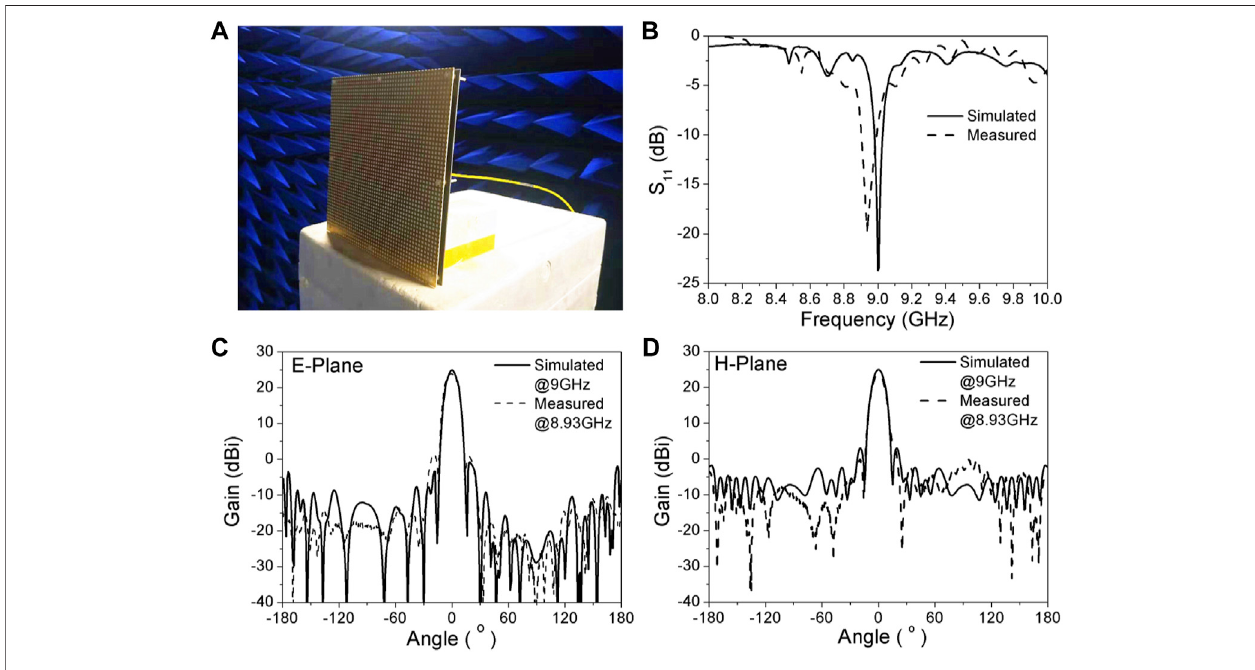
FIGURE9| PerformanceoftheMNMantenna,wherethesolid(dashed)linedescribesthesimulated(experimental)results. (A) Antennaimageinthedarkroom. (B) Return loss S 11 . (C) Realized gain in the E-plane. (D) Realized gain in the H-plane.